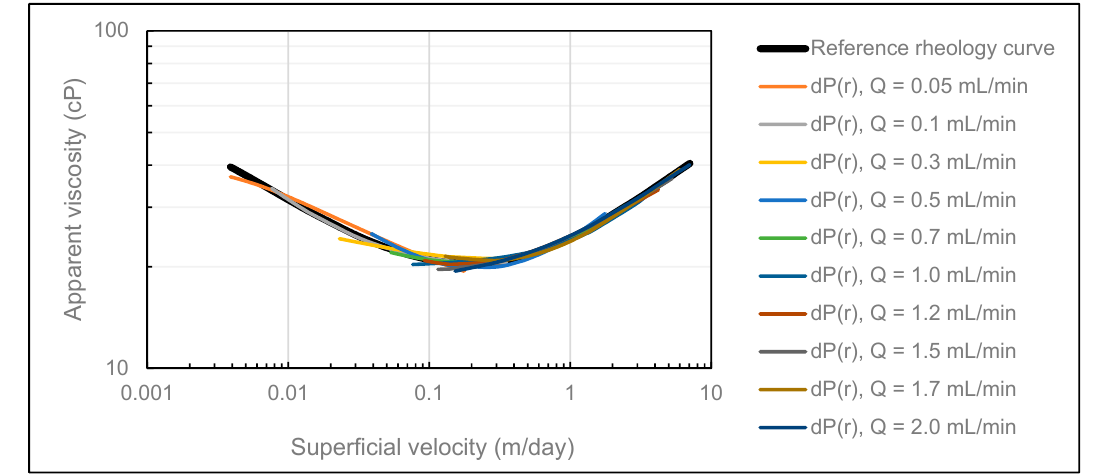
Figure 3. Comparison of the reference rheology curve (black) and rheology curves obtained in CMOST when the reference dataset was history matched using the DMM.